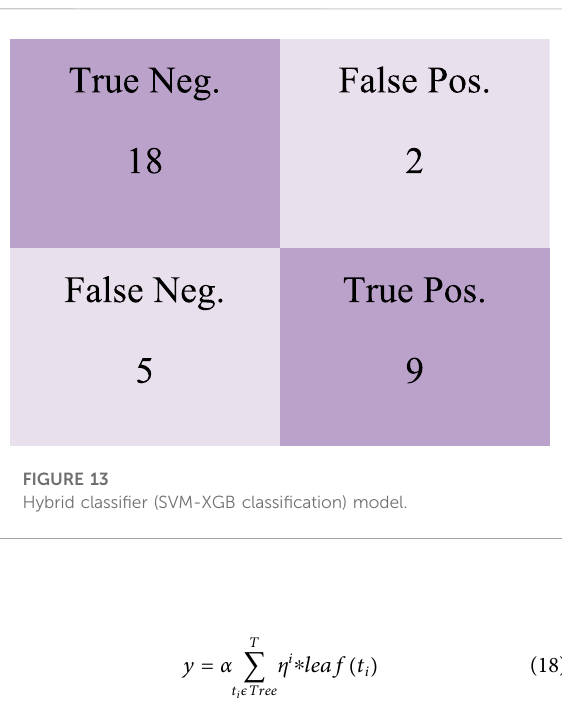
FIGURE 12 SVM-LGB classi fi cation model performance.